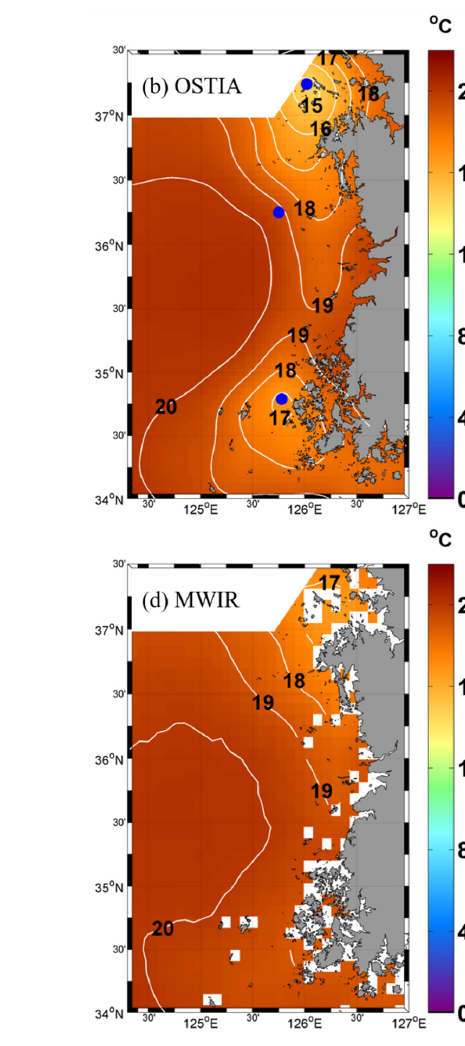
Figure 10. Horizontal distribution of the ( a ) in situ CTD (NIFS and KOEM), ( b ) OSTIA, ( c ) OISST, and ( d ) MWIR SST for June from 2010 to 2013. The blue points in ( b ) are the locations of the KMA buoys, which observe SST.